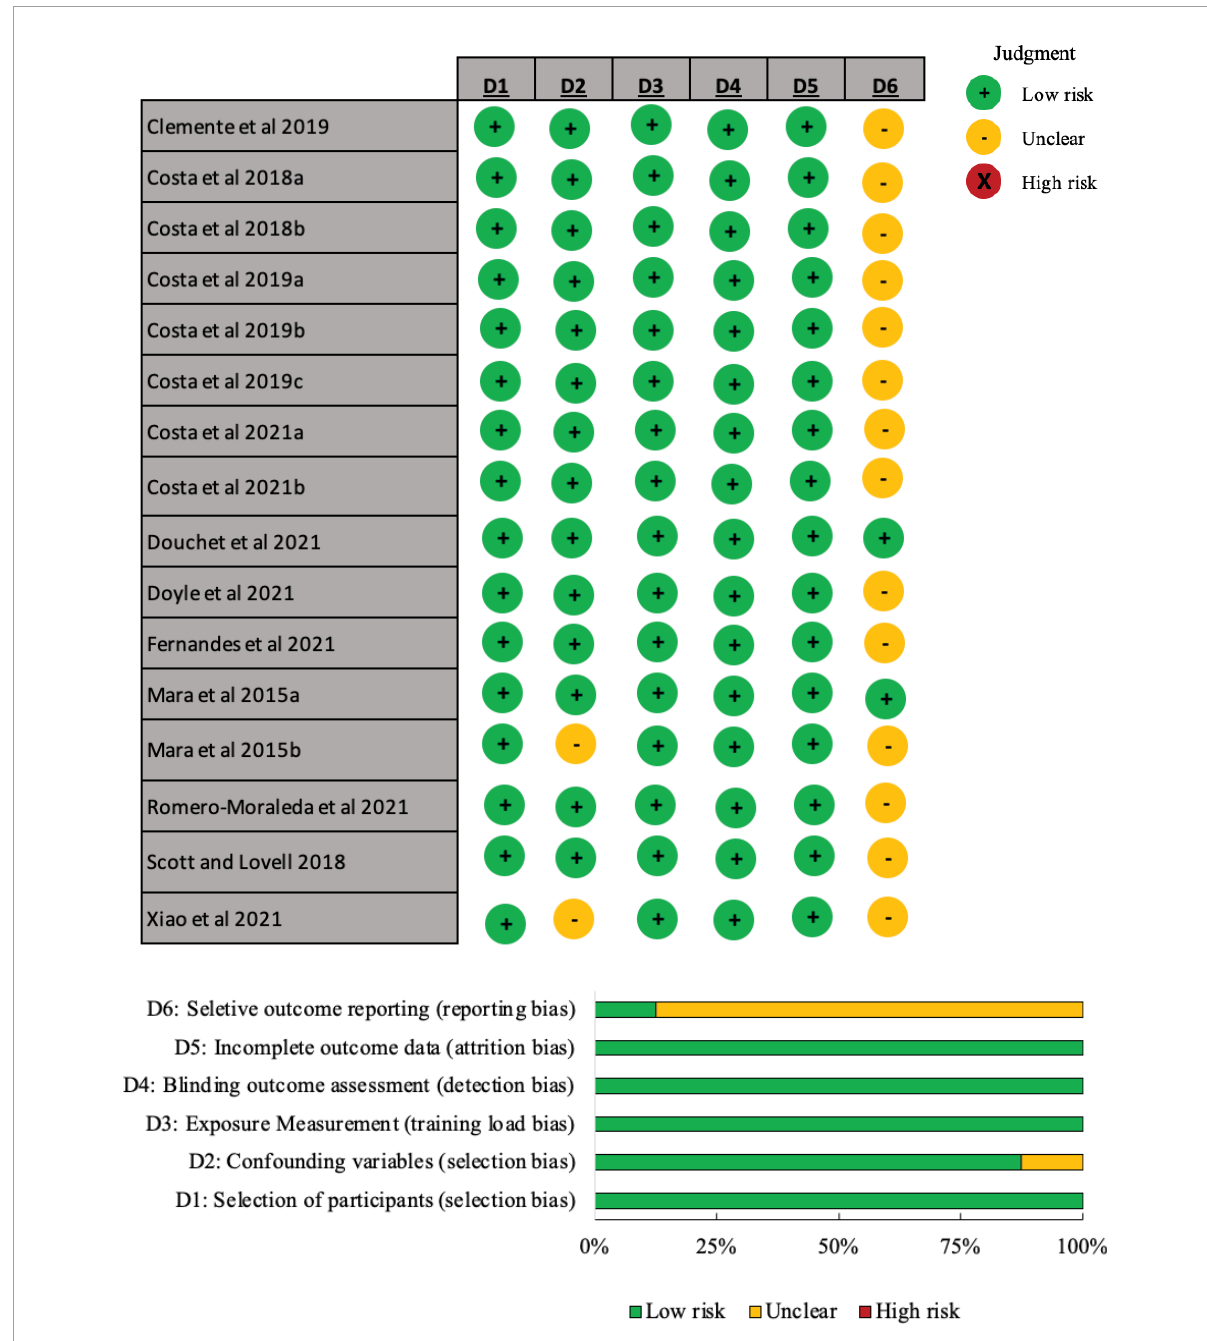
distance) on the previous day during a tournament (Scott and Lovell, 2018). Scott and Lovell (2018) described that self-reported fatigue and muscle soreness were negatively associated (small magnitude) with high- speed distance covered ( r = − 0.20) using either fixed ( > 12.6 km/h − 1 ) or individual thresholds during a